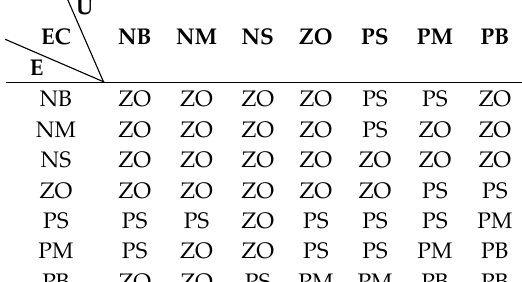
Table 8. Fuzzy control strategy for guide plate II.